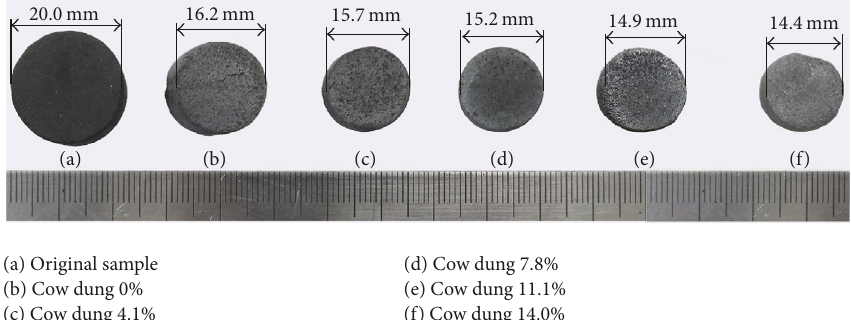
Figure 6: Size of the carbon-bearing pellets before and after reduction roasting.